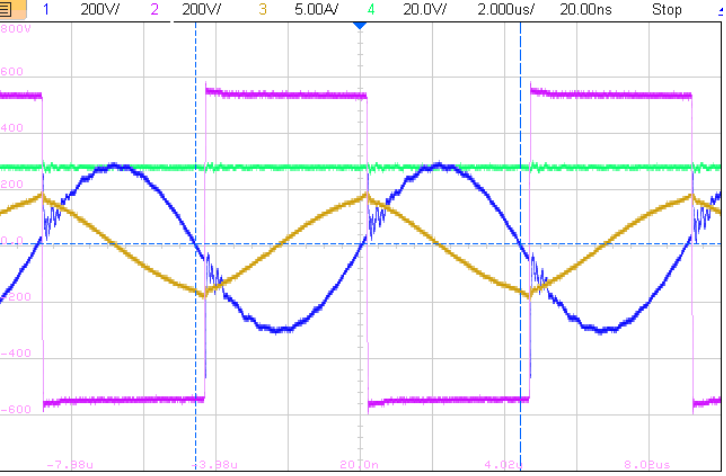
Figure 16. Experimental result of the prototype LLC converter demonstrating: 1. resonant capacitor voltage (V Cr ), 2. primary side transformer voltage (V pri ), 3. resonant inductor current (I r ), and 4. output voltage (V o ) before